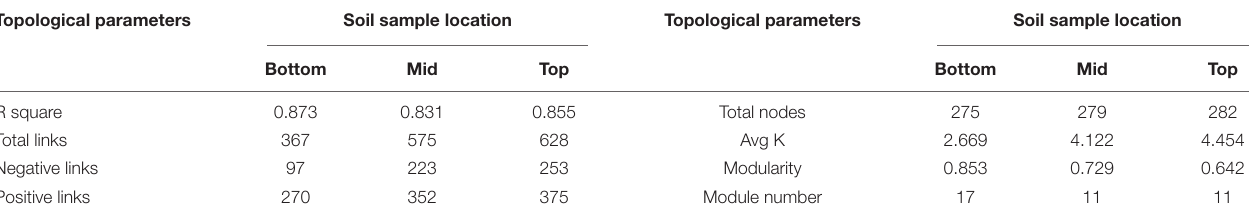
FIGURE 1 | The study area and sampling sites of coal mining subsidence. (A) Sampling points of land subsidence in Daliuta coal mine, (B) Schematic diagram of the sampling point location, (C) Location of Daliuta coal mine, (D) Relative position of the sampling points. The photographs of the (E) Top, (F) Middle, and (G) Bottom of the slope. TABLE 1 | Topological property of the empirical molecular ecological networks of microbial communities and their random networks at different locations of the subsidence area. Topological